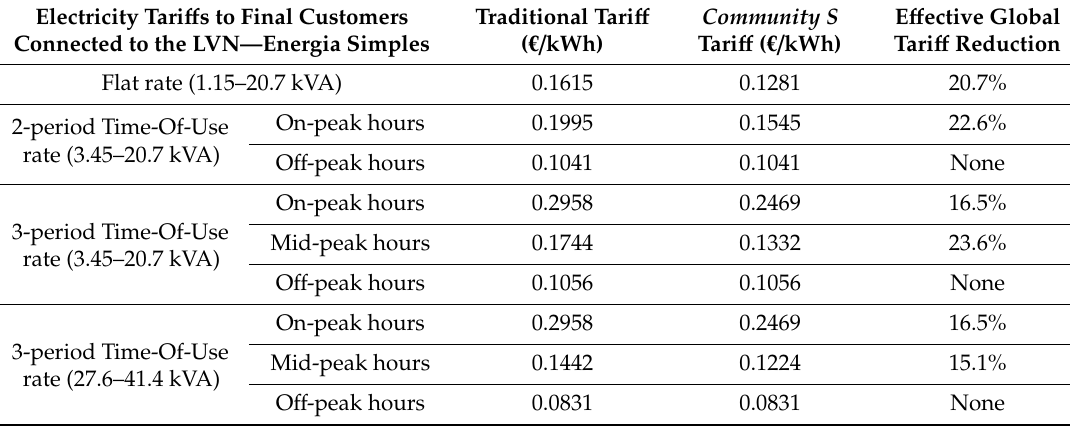
Table 2. Energy contract tailored by Energia Simples for participants of the Community S project, which encompassed the proposed NAT reductions for the surplus electricity shared within each